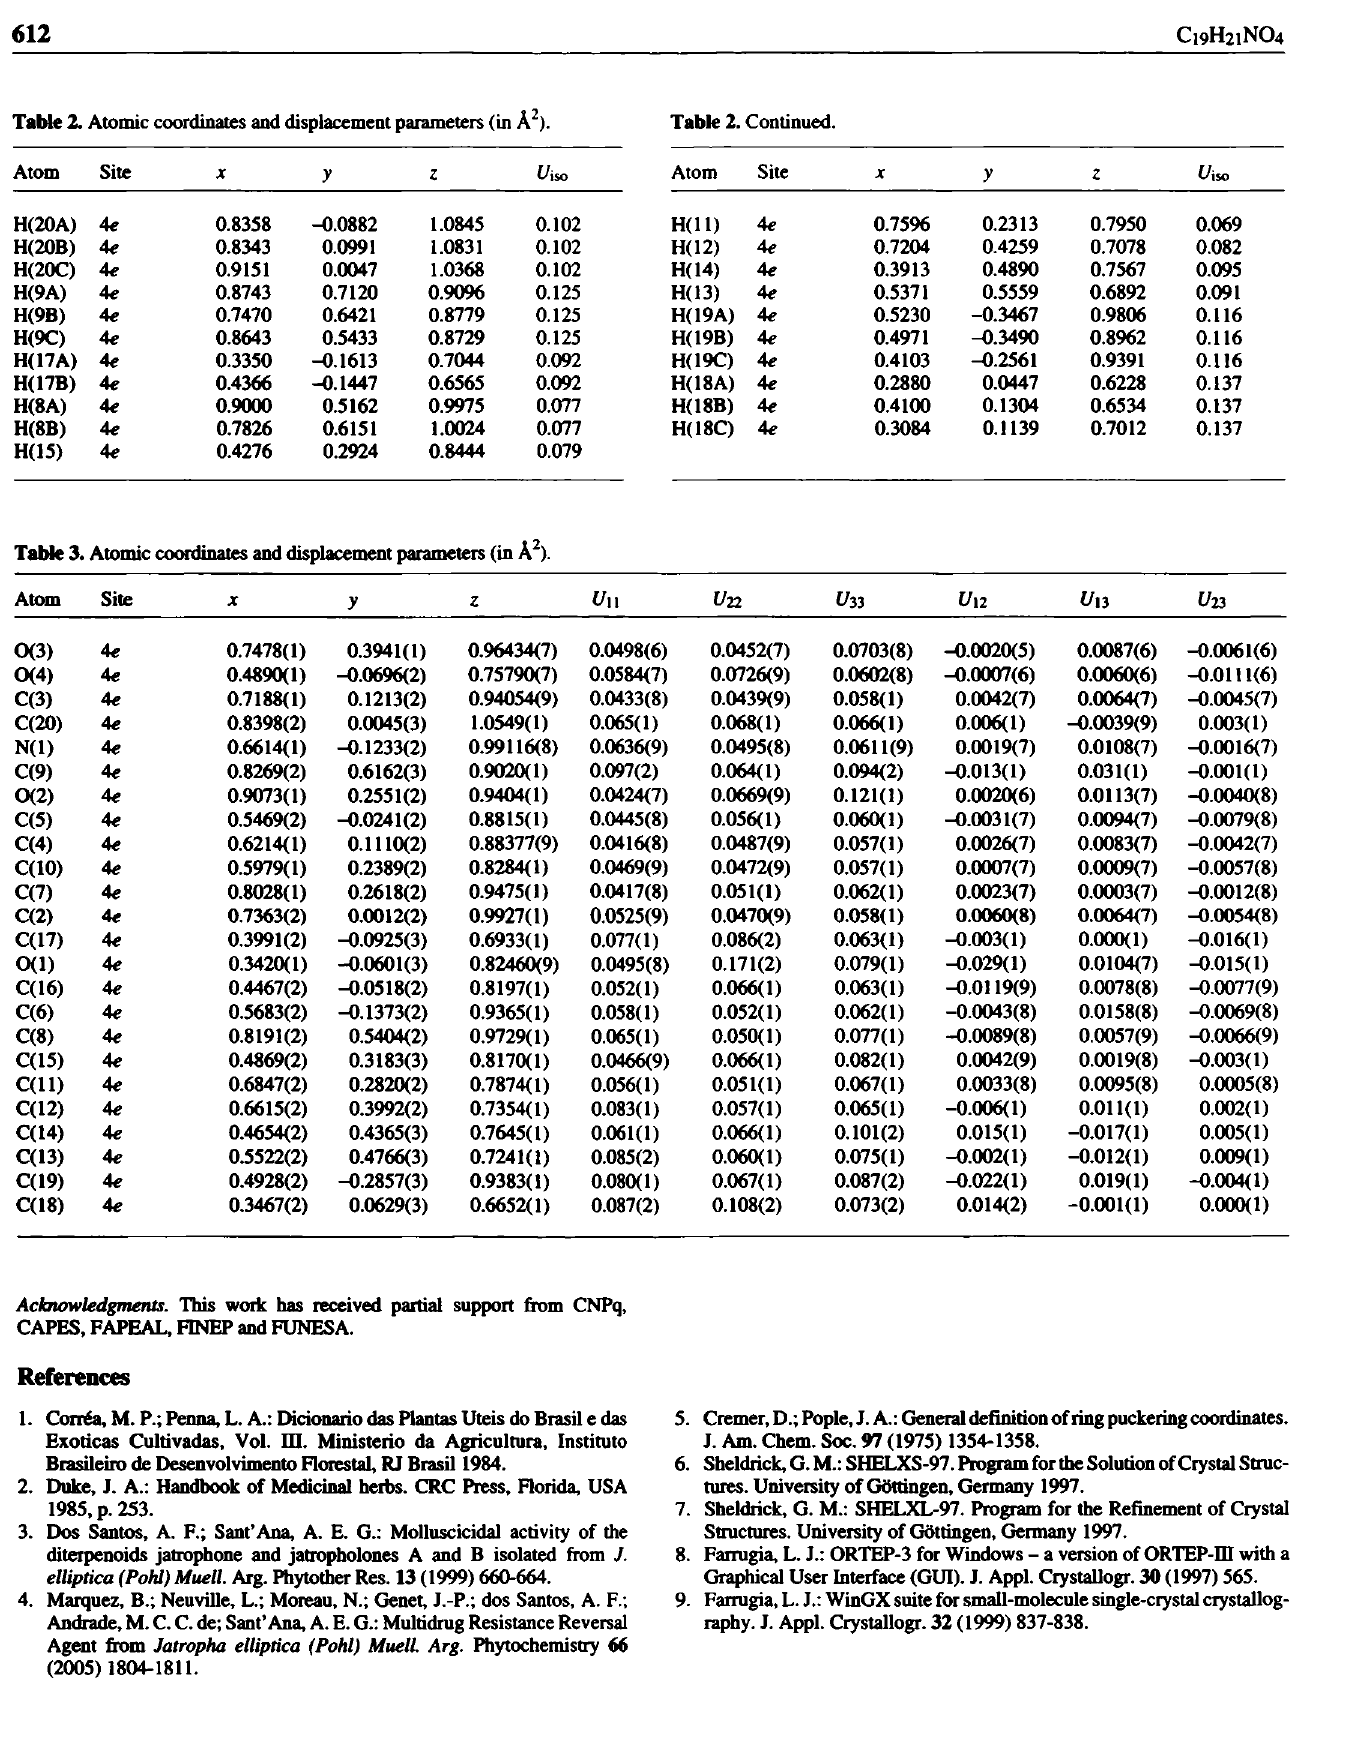
Table 2. Atomic coordinates and displacement parameters (in A 2 ).